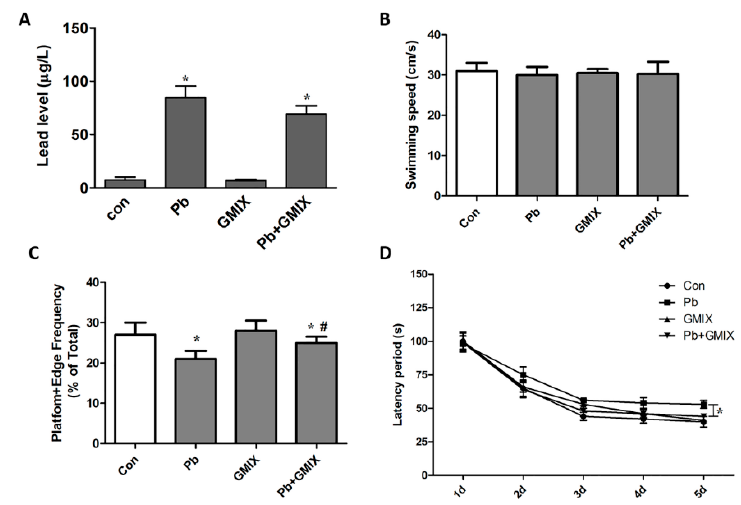
Figure 1. Gangliosides attenuates Pb-induced injuries in spatial reference memory. ( A ) The blood lead levels (BLLs) in four groups of rats; ( B ) Swimming speed in the water maze on the first day of the training; ( C , D ) The percentage of time spent in the target quadrant, as indicated by the percentage of time swimming across the area or the edge of the target quadrant to the four quarters. The data are expressed as means ˘ SD. * p < 0.05 vs. control group; # p < 0.05 vs. Pb group.